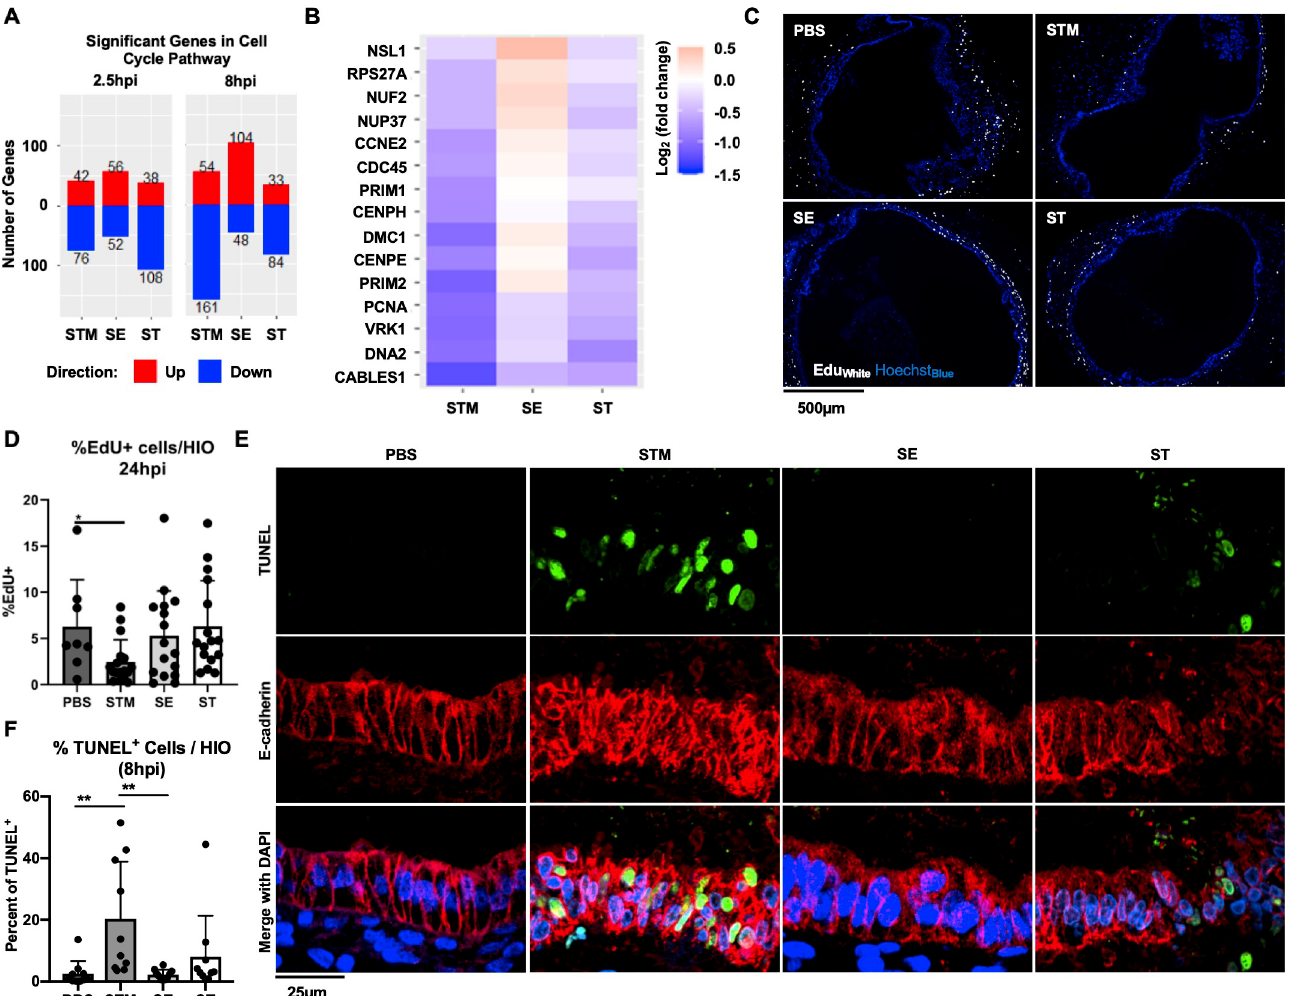
Fig 5. STM suppresses host cell cycle and induces cell death. (A) The number of significant genes in the cell cycle pathway upregulated (red) or downregulated (blue) in each condition. (B) Top differentially expressed cell cycle genes sorted by greatest standard deviation between STM and SE conditions. (C) EdU staining in HIOs at 24hpi. EdU (white), Hoechst (blue). (D) Quantitation of EdU staining with n > 8 HIOs. (E) TUNEL staining in HIOs at 8hpi. TUNEL (green) E- cadherin (red) DAPI (blue). (F) Quantitation of TUNEL staining with n = 10 HIOs. Significance was determined by unpaired t-test where P value: � < 0.05 and �� <